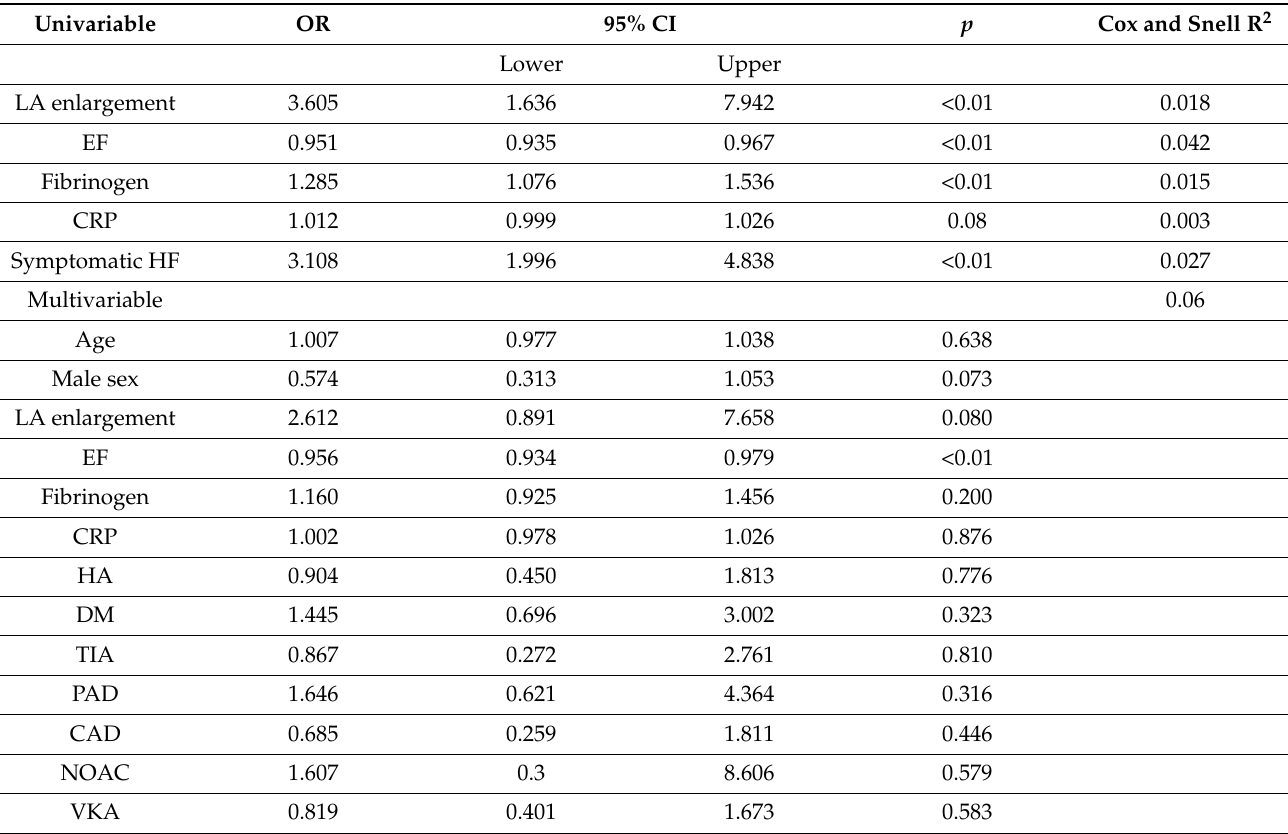
Table 2. Multivariable and univariable logistic regression